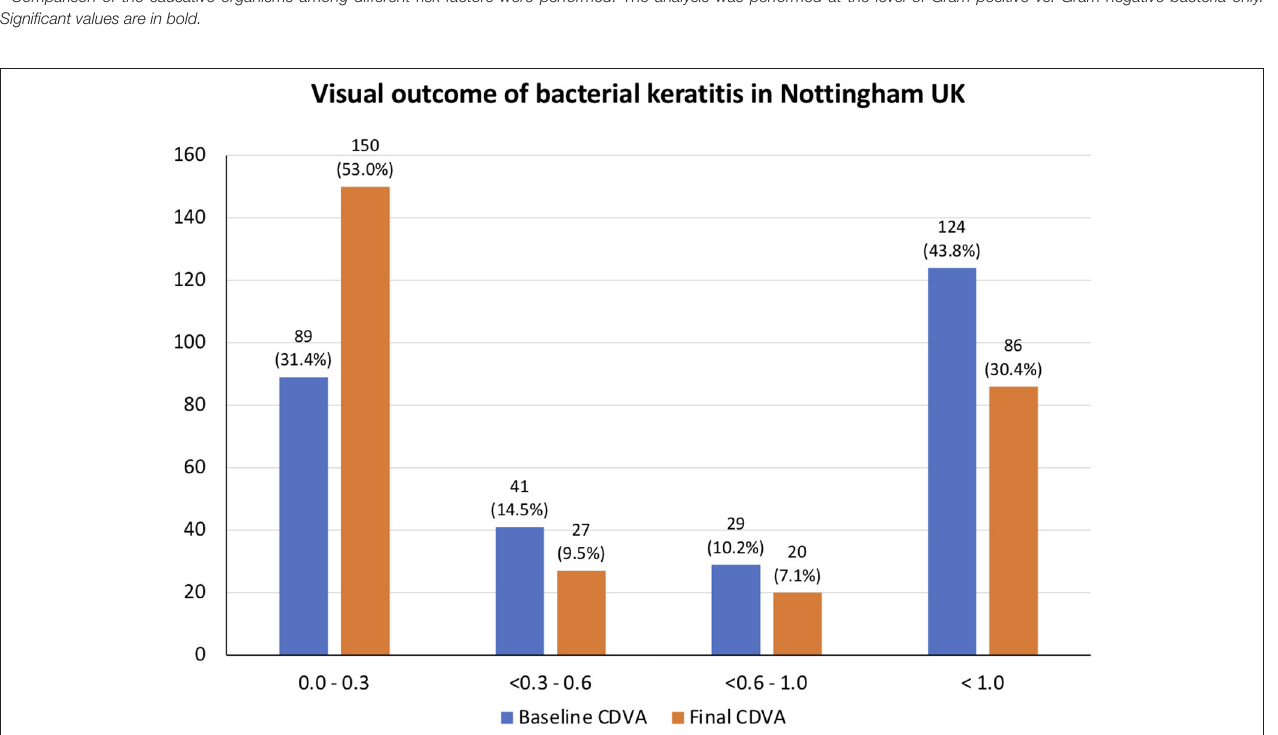
influence the visual outcome or the corneal healing time (all p >